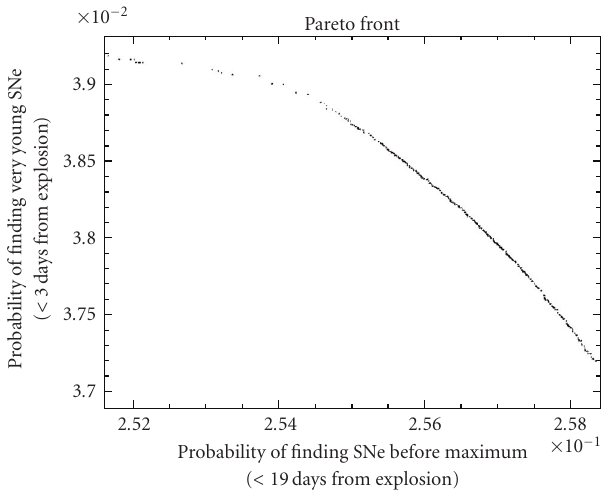
Figure 4: Locus of Pareto-optimal solutions, or Pareto front, using two objective functions: the probability of finding SNe before maximum (abscissa) and the probability of finding SNe no later than three days after the explosion (ordinate). In this example we have evolved 10,000 generations of 1,000 observational plans each, similar to the simulation shown in Figure 3, but with two objectives instead of only one. Absolute numbers should not be trusted, since the simulated cadences are too big for the values expected in a survey looking for SNe as young as three days after explosion. Individual points represent individual observational plans, and the set of points are only an approximation to the Pareto front. Once the Pareto front is computed, one observational plan from the set of solutions can be chosen according to arbitrarily defined